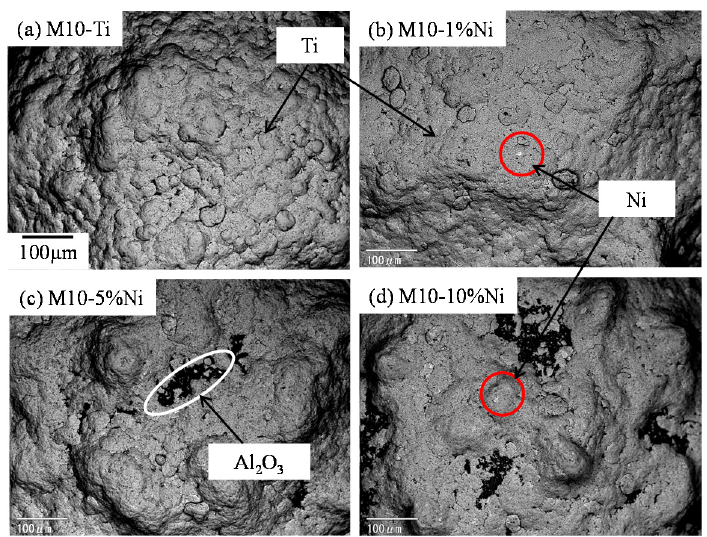
Figure 42. SEM images of surface structure of the M10- x Ni samples.